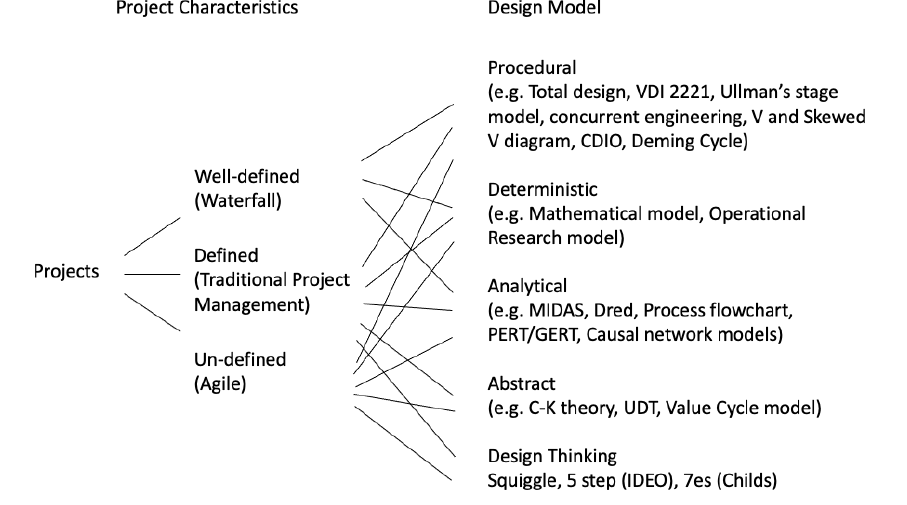
Figure 1. Classification of design methods.